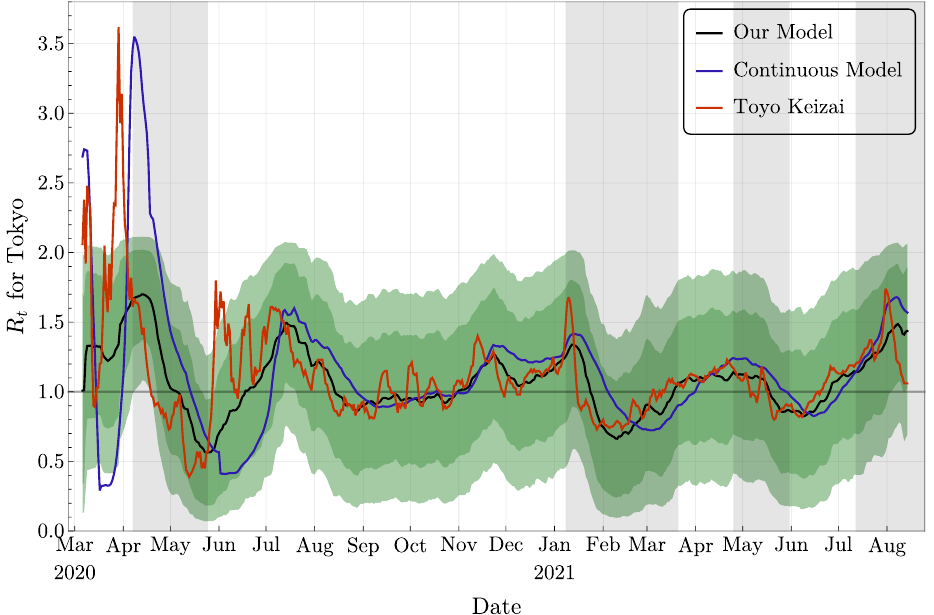
Figure 12. The effective reproduction number for Tokyo computed with different approaches: the black curve and the green confidence intervals are from our approach, the blue curve is provided by [44], and the red curve is borrowed from [42].